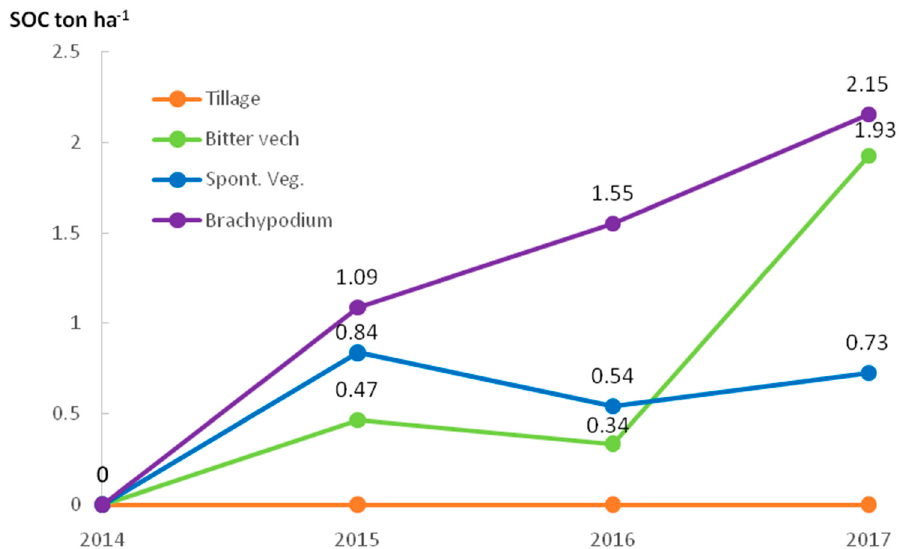
Figure 3. Mean soil organic carbon increase regarding tillage at 0–5 cm depth in the studied years in the different treatments.